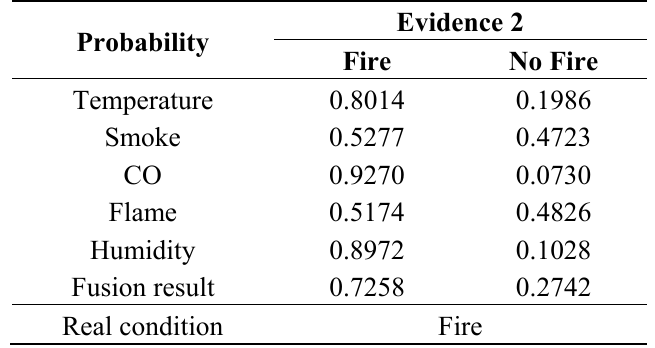
Table 3. Fire probability data and fusion result under Condition